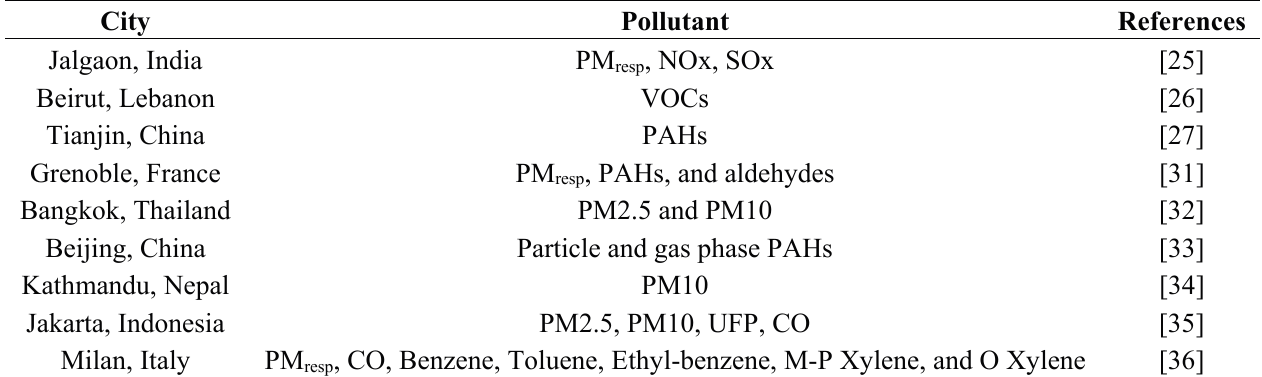
Table 1. Overview of past pollutant exposure studies among traffic police